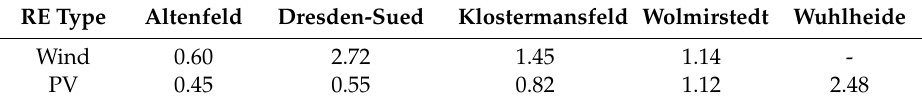
Table 6. Forecast improvements of substation-specific wind and PV generation forecasts (in %). RE Type